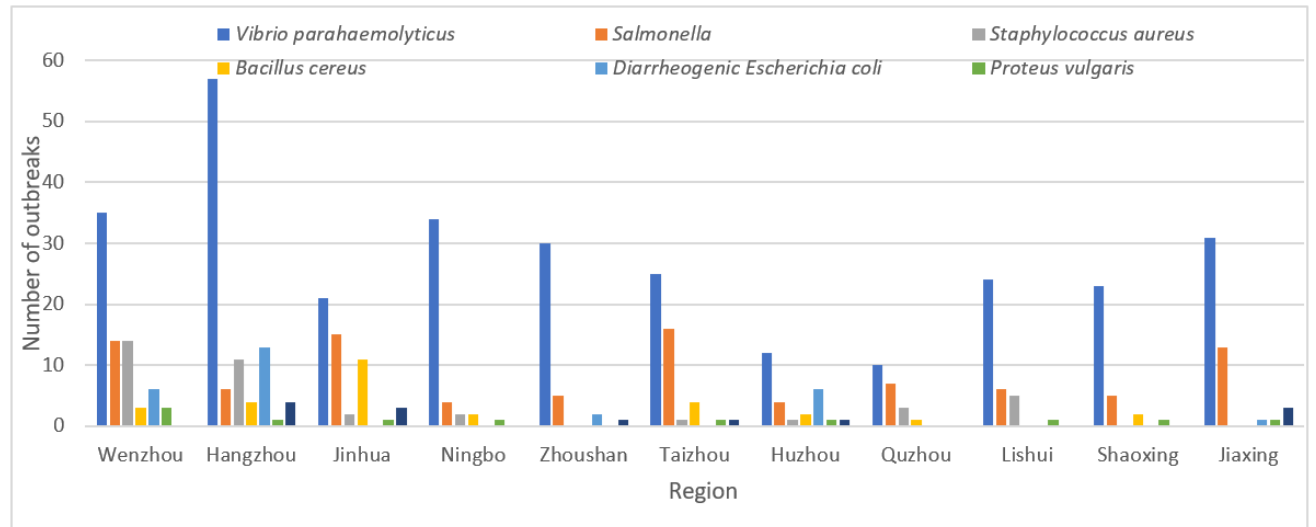
Figure 2. Region-etiology distribution of outbreaks of bacterial FBDOs in Zhejiang Province, 2010–2020.